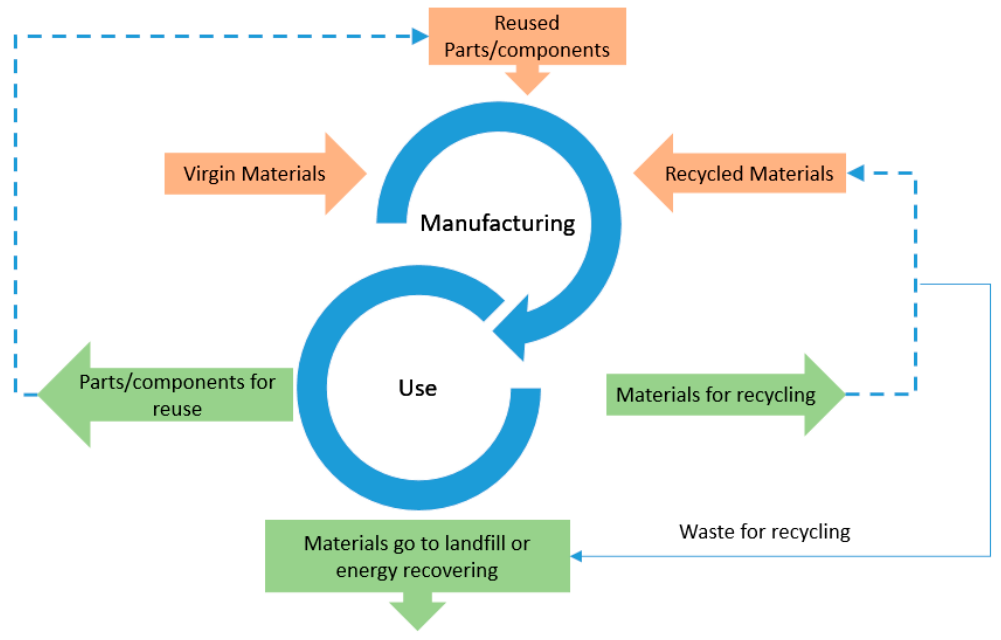
Figure 3. Material flows of technical materials Circularity Indicators Methodology.